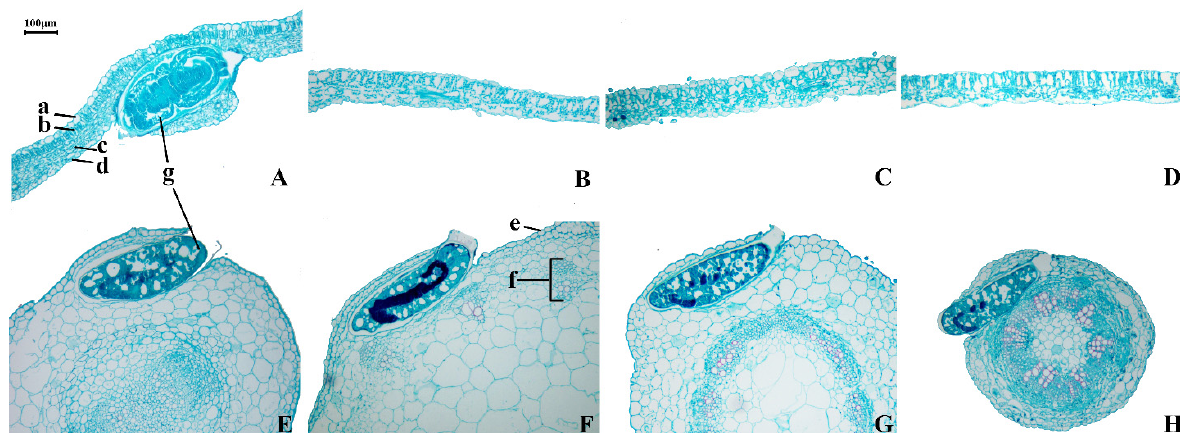
Figure 7. Cross-section of leaves and stems of four different plant species. ( A ) Coriander leaf; ( B ) marigold leaf; ( C ) sweet alyssum leaf; ( D ) alfalfa leaf; ( E ) coriander stem; ( F ) marigold stem; ( G ) sweet alyssum stem; ( H ) alfalfa stem; (a) upper epidermis; (b) palisade tissue; (c) spongy tissue; (d) lower epidermis; (e) epidermis; (f) vascular tissue; (g) eggs of Orius sauteri . Scale bars: A-H, 100 μ m. Magnification: 100×.